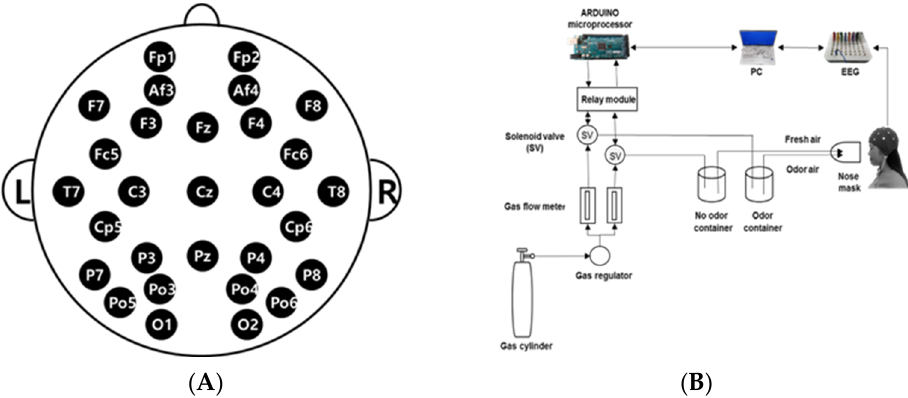
Figure 1. EEG experiment: ( A ) EEG electrode placement locations using the International 10–20 sys- tem; ( B ) Schematic diagram of the experimental